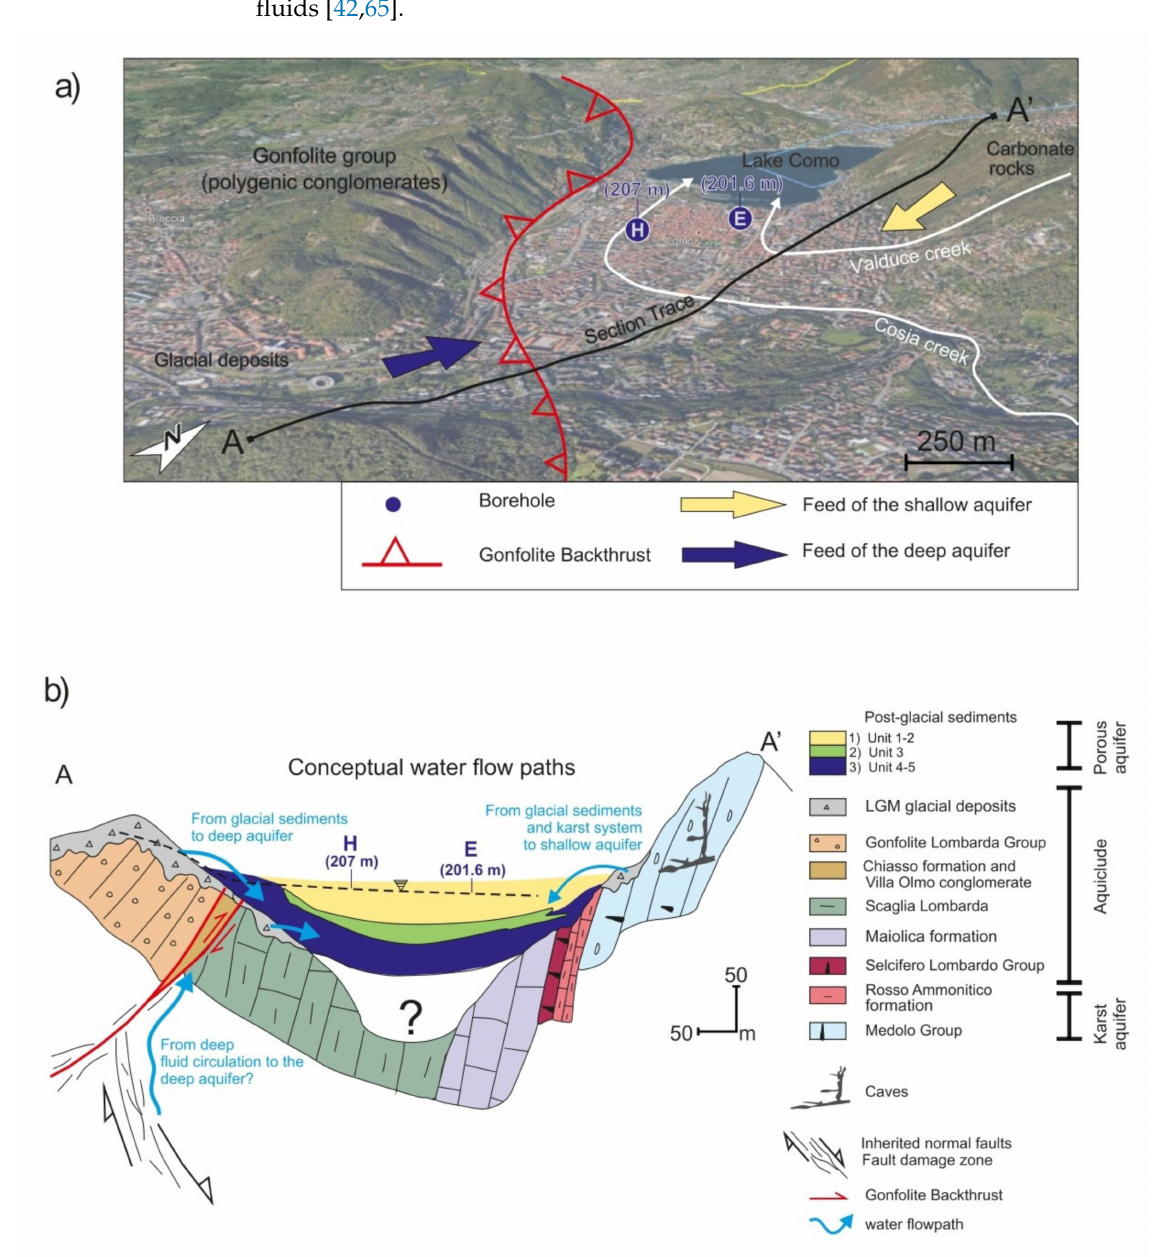
Figure 7. ( a ) Recharge areas and flow pathways (arrows) feeding the shallow and deep aquifers in the Como region. Section A-A’ is indicated with a black line (see Figure 1b for its detailed spatial location). Boreholes H and E are shown (the reader is referred to Figure 2a for their location on map) together with the elevation of the hydraulic head of the deep aquifer (in parentheses, expressed in m a.s.l.). Basemap: Google Earth imagery. ( b ) Sketch of the conceptual model for water circulation and recharge areas through the section of Como basin along the section A-A’. Boreholes H and E are also indicated, including the current inferred line of hydraulic head (black dashed line). Details on the different geological formations can be found in